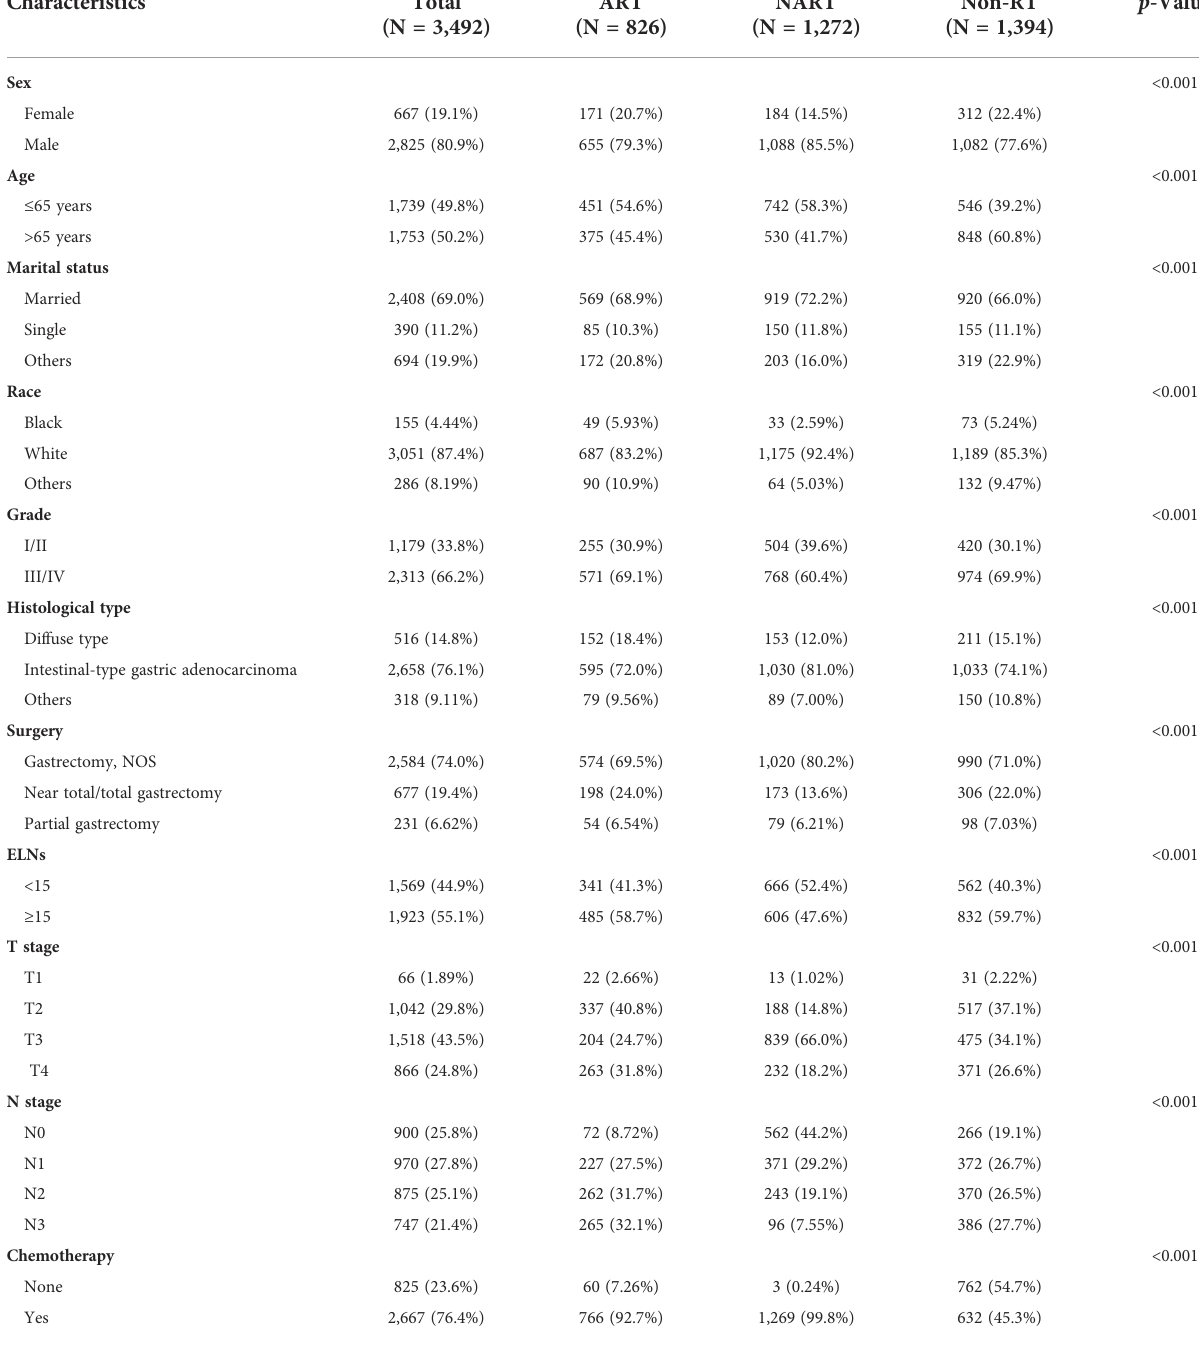
TABLE 1 Clinical and pathological features in patients with stage II – III gastroesophageal junction adenocarcinoma, strati fi ed by RT sequence.